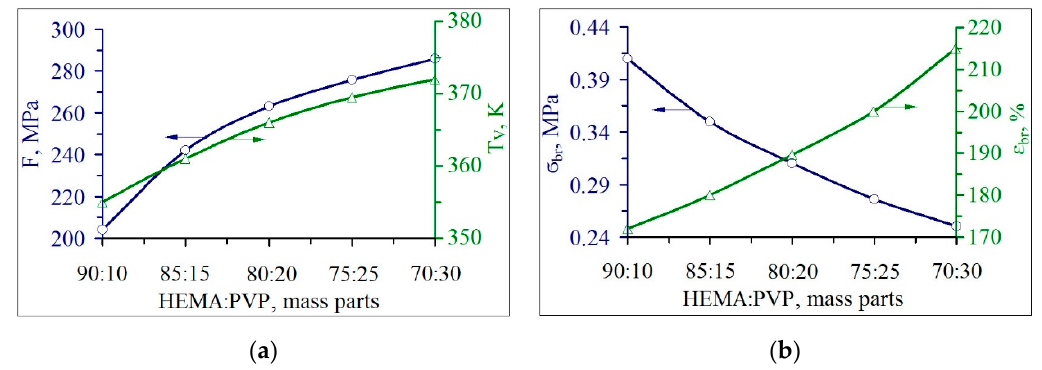
Figure 7. The effect of the initial composition formulation on the properties of block copolymers in the dry ( a ) and swollen state ( b ).